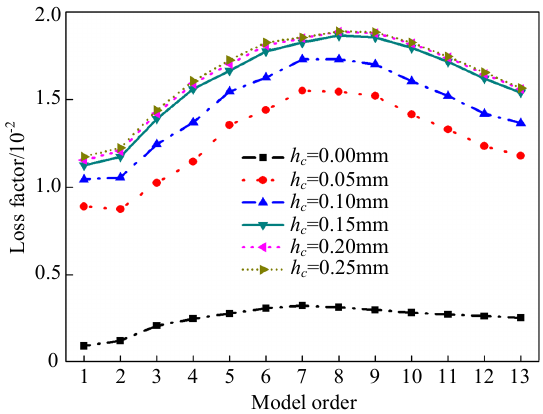
Figure 9. Modal loss factors of the blisk with different coating thicknesses.